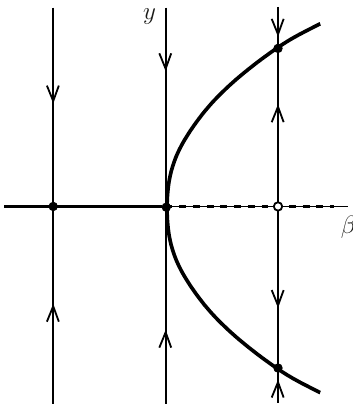
Figure 24. Supercritical pitchfork bifurcation in the system _ y = (cid:12)y